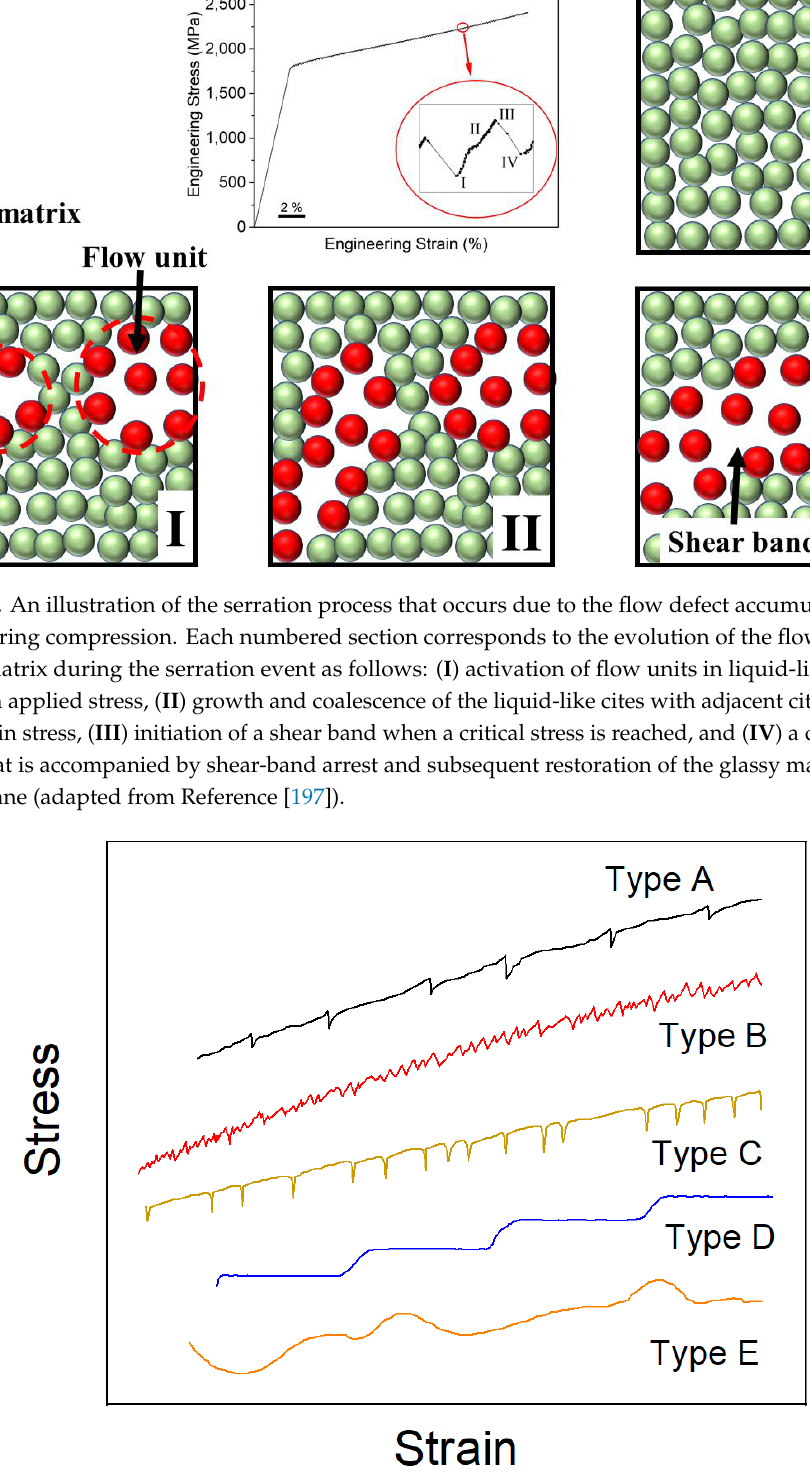
Figure 10. The five types of serrations that can occur during mechanical testing (adapted from References